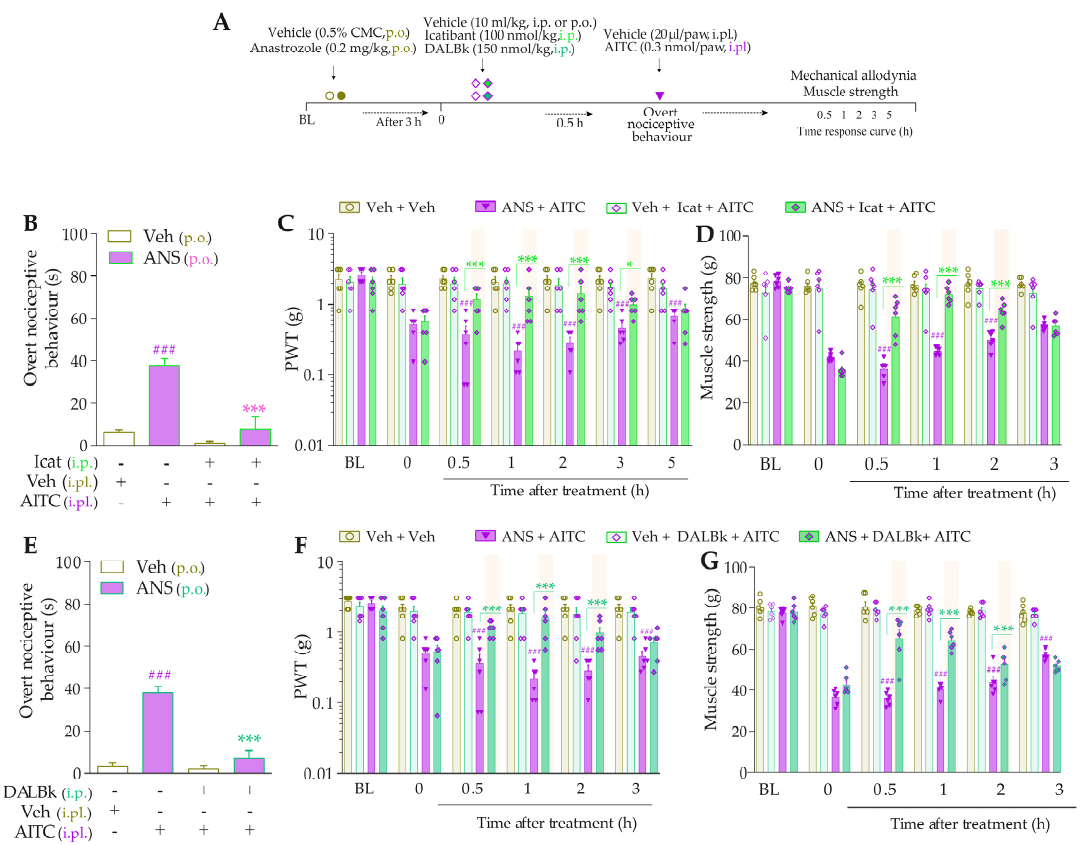
Figure 5. Kinin B 2 and B 1 receptors contribute to the nociceptive behaviors induced by the TRPA1 agonist in anastrozole-treated mice. ( A ) Male C57BL/6 mice were treated by the oral route (p.o.) with anastrozole (0.2 mg/kg) or its vehicle (0.5% CMC) to induce painful behaviors. At 3 h after anastro- zole administration (Time 0), the animals received a single administration of Icatibant (150 nmol/kg, i.p.) or DALBk (100 nmol/kg, i.p.). After 0.5 h, vehicle (20 µL/paw, intraplantar, i.pl.) or AITC (0.3 nmol/paw, i.pl.; sub-nociceptive dose) were injected by the intraplantar route. The overt